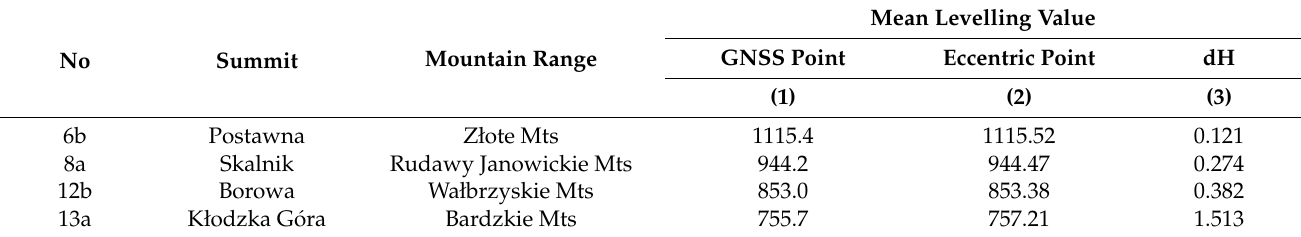
Table 2. The results of geometric levelling measurements between the GNSS point and eccentric points [m].